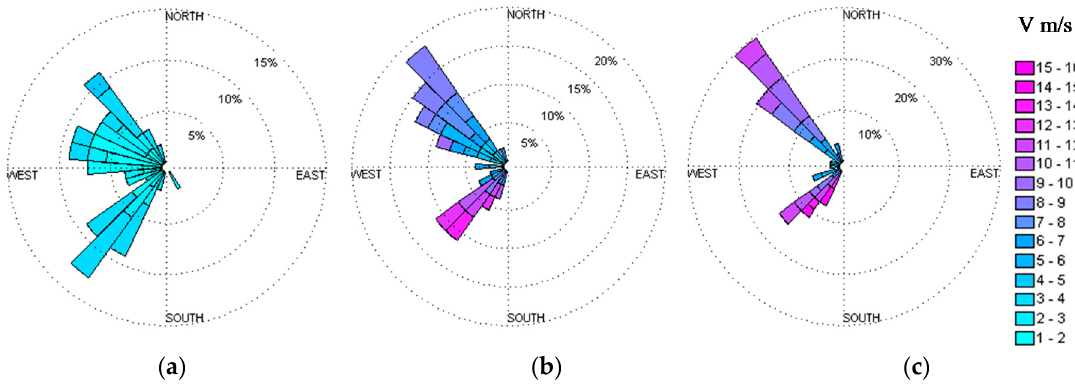
Figure 3. P1 wind roses for ( a ) NUIG measured wind, and HR modeled winds at ( b ) C1 and ( c ) A2.